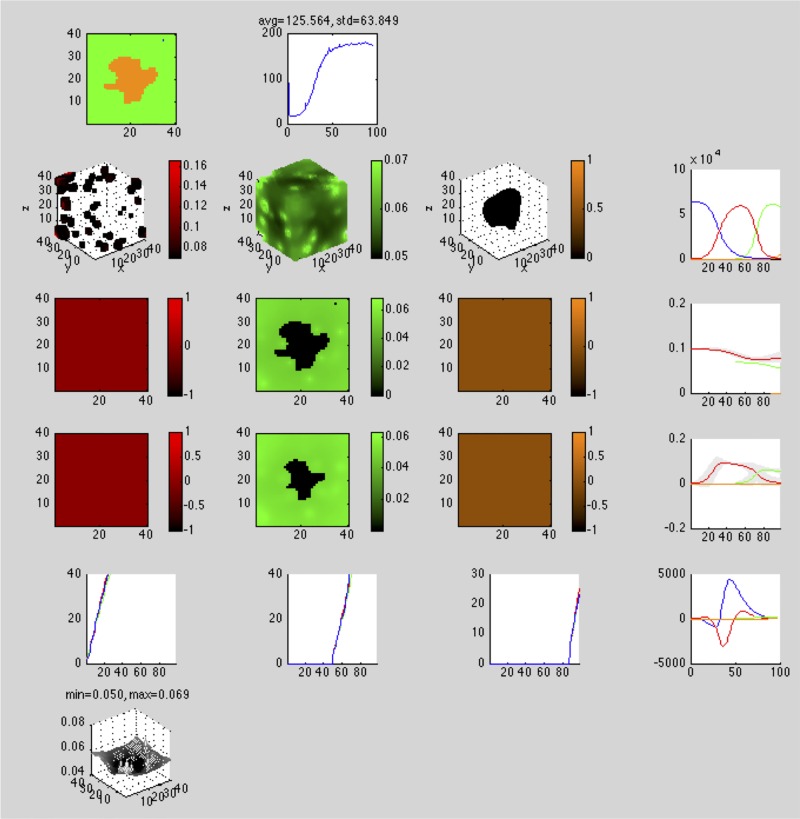
3D simulation console.Simulator console displaying evolving regions of stable chronic hypoxia with many vessels in a 40 × 40 × 40 lattice. The simulation consists of five cell types—vessel (white), empty (blue), viable (red), hypoxic (green), and necrotic (orange)—and one particle type, O2. In row 1, column 1, the cell population at this point in the simulation consists of hypoxic and necrotic cells. In rows 2-5, columns 1-3, all cell types except vessel and empty have fitness and other spatial statistics reported. In row 6, the concentration of O2 is reported. In column 4, rows 2-5, aggregate cell type statistics are reported in time series. Components of the console displaying 2D plots show the plane z = 20.